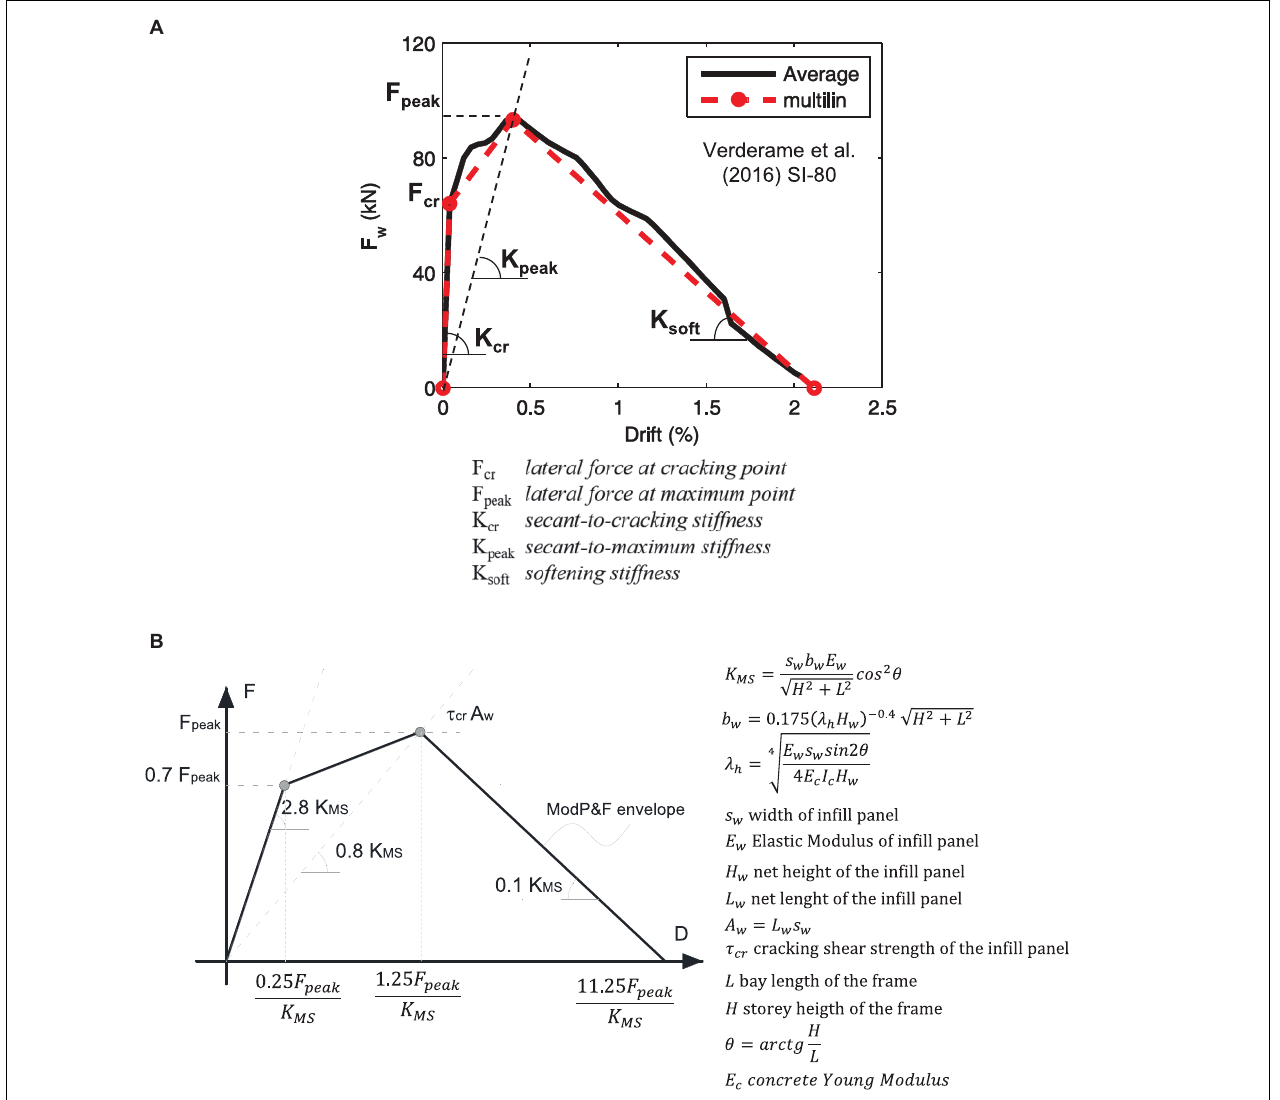
FIGURE 1 | Infill lateral response: multi-linearization of experimental data (A) and Modified Panagiotakos and Fardis (ModP&F) model by De Risi et al. (2018) (B) (adapted from De Risi et al.,